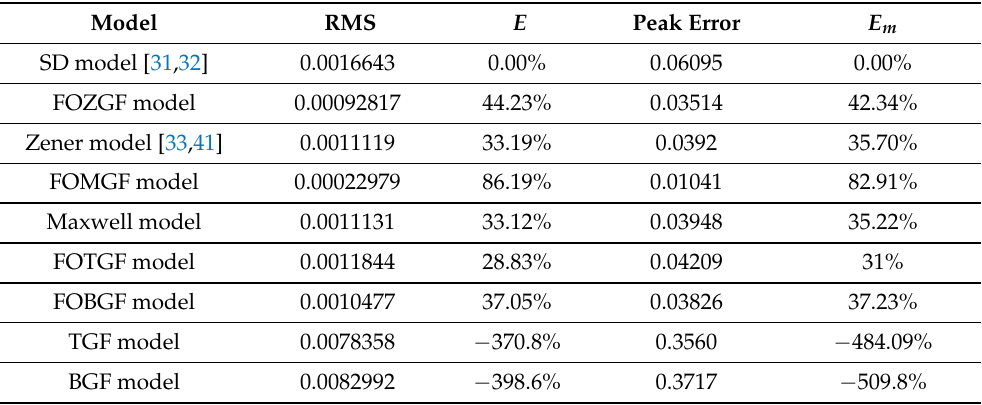
Table 2. Error values of different